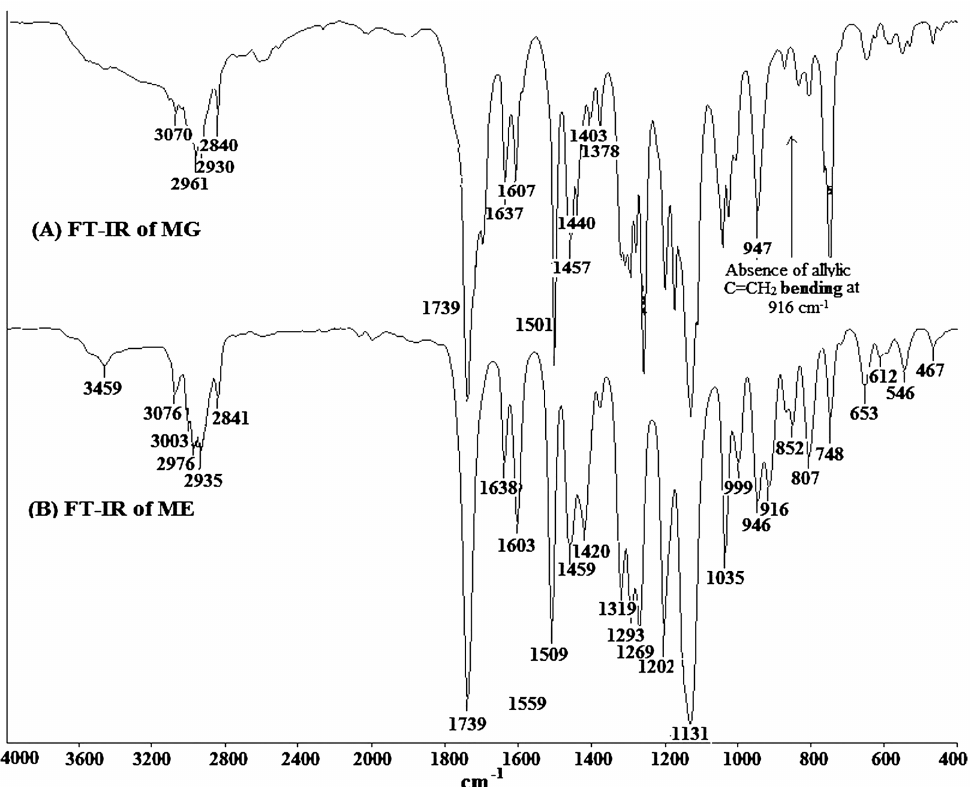
Figure 3: FT-IR of (A) ME and (B)